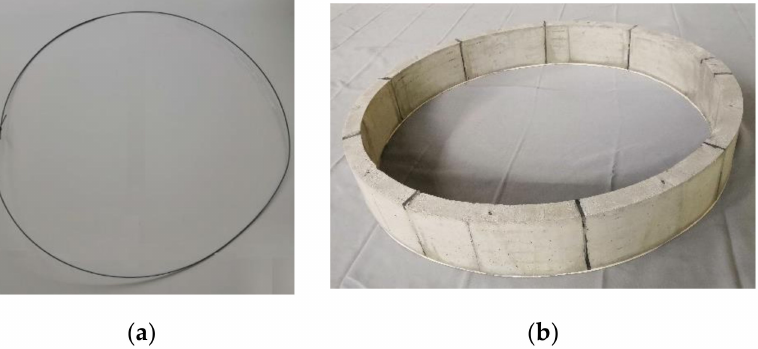
Figure 5. Model ring of segmental lining. ( a ) Steel wire. ( b ) Sealant in an assembled ring.